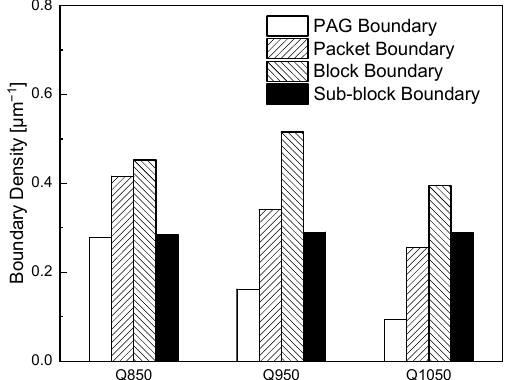
Figure 4. Comparison of density according to different grain boundary type.